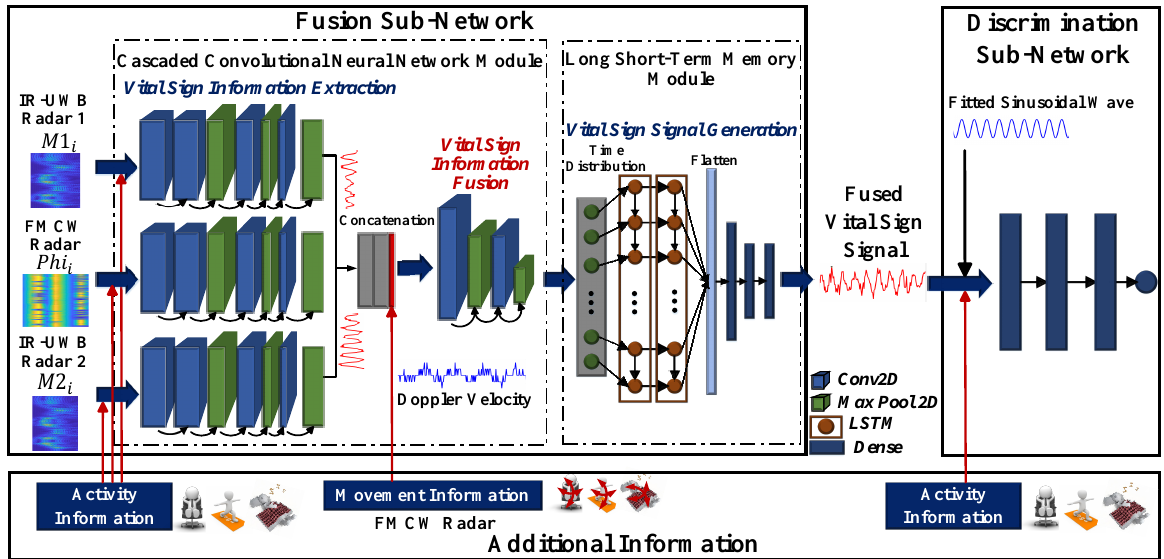
Figure 5. Structure of the proposed A-FuseNet for vital sign